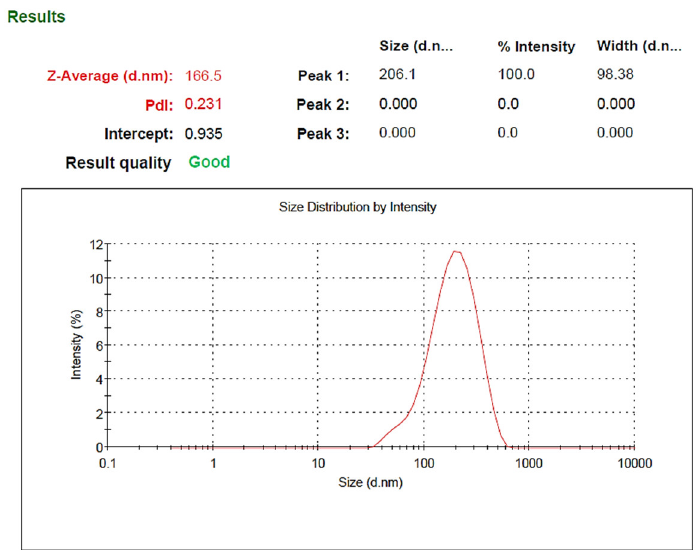
Figure 1. FE-SEM image of SeN. According to the picture, the size of nanoparticles is about 200 nm.